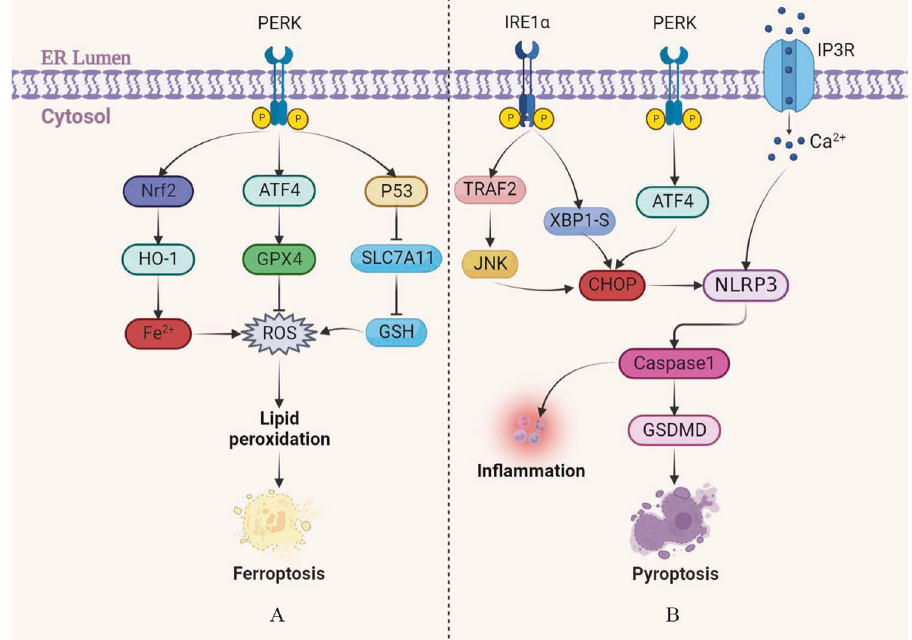
Fig. 4 Ferroptosis and pyroptosis involved in the UPR pathway. A The ferroptosis pathway caused by ERS is mainly induced by the PERK pathway, which involves the metabolism of Fe 2 + in cells, the accumulation of lipid peroxides caused by glutathione depletion, and eventually leads to the occurrence of ferroptosis. B Pyroptosis is mainly mediated by PERK, IRE1 α , and Ca 2 + pathways of ERS. After PERK and IRE1 α are activated, the downstream NOD-like receptor thermal protein domain associated protein 3 (NLRP3) is activated to induce in fl ammation and pyroptosis. In addition, Ca 2 + can also induce pyroptosis by directly acting on